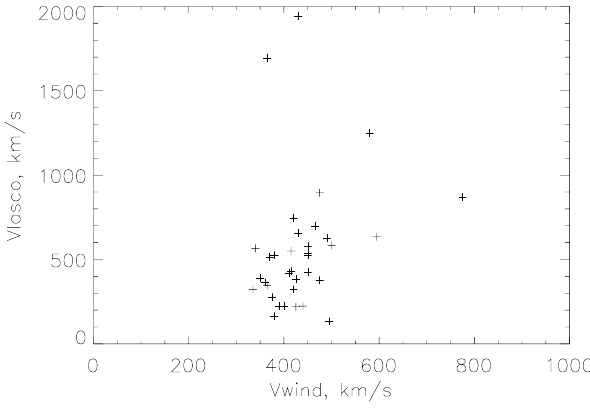
Fig. 4. Scatter plot of the CME’s apparent speed V LASCO with respect to the Ips velocity V WIND measured at WIND.